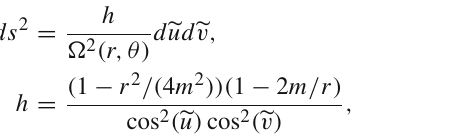
Fig. 3 Penrose diagram of the super-accelerating black hole with 2 mA > 1. H E refers to the event horizon, H A to the acceleration horizon, and I to the conformal infinity. The diagram is actually a superposition of different diagrams for each value of θ . The location of the conformal infinity depends on θ . It is placed at the event horizon for